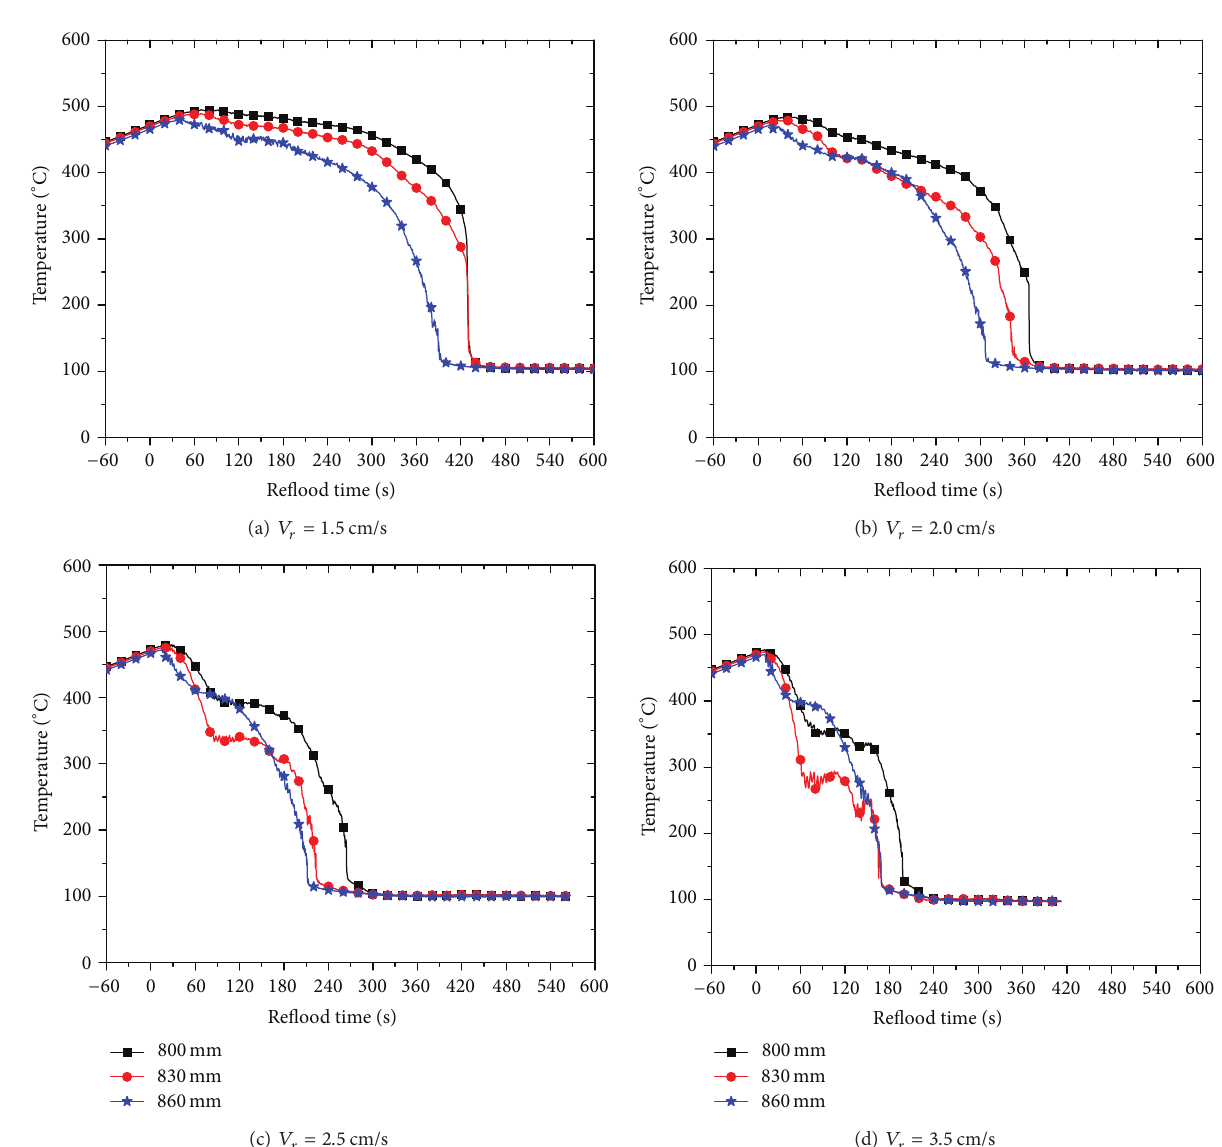
Figure 9: Temperature profiles in the blockage internal region for 𝑄 = 1.5